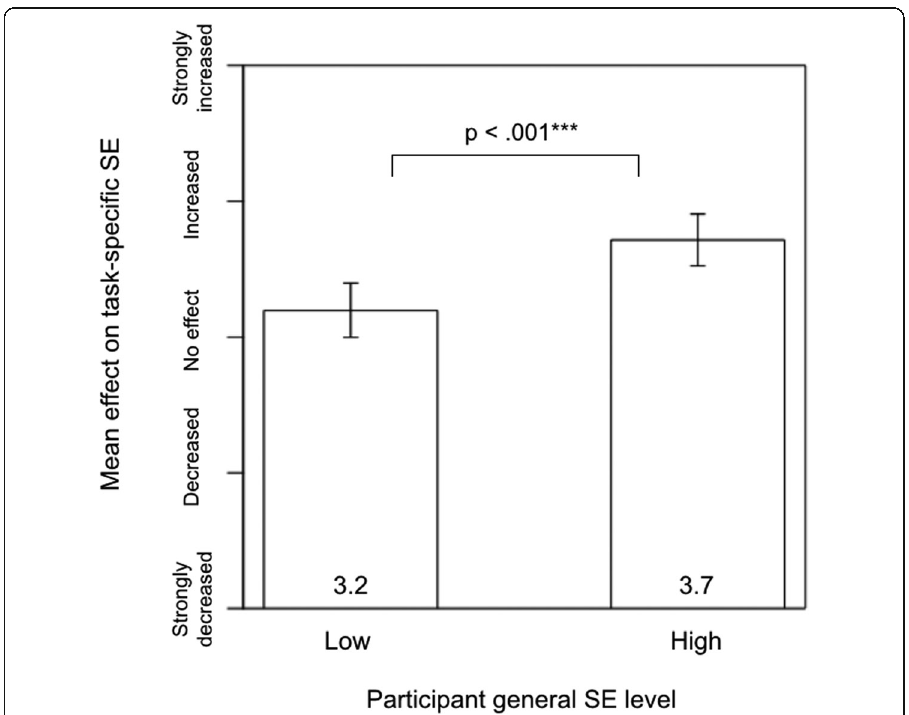
Fig. 6 A comparison of the mean effect of VEI on task-specific SE between participants with low and high levels of general